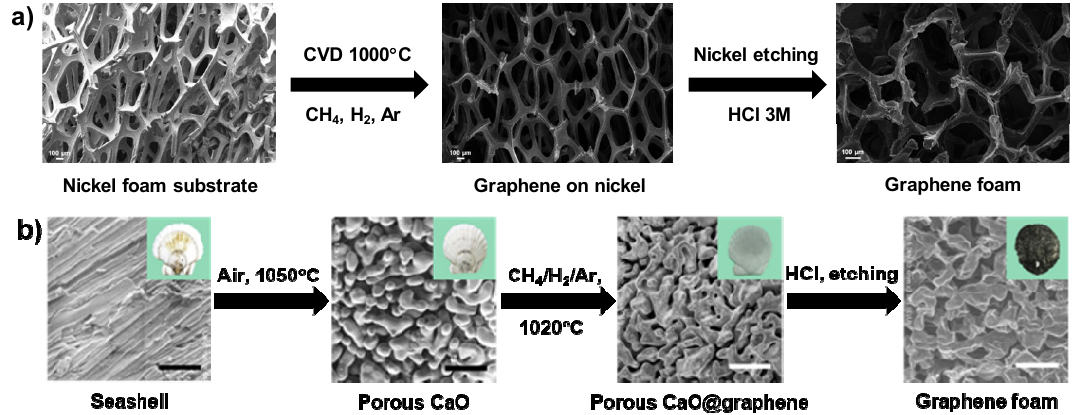
Figure 1. Synthesis of 3D graphene foam on ( a ) metallic and ( b ) seashell templates. First row ( a ): SEM images of Ni template, graphene-coated Ni after CVD growth, and free-standing graphene foam after removing the Ni template [13]. Second row ( b ): SEM images of pristine seashell microstructure, calcined seashell, graphene-coated calcined seashell after CVD growth, and 3D graphene foam after removal of the CaO template. All scale bars are 5 µm . Reprinted with permission from ref. [14]. Copyright the 2016 American Chemical Society.